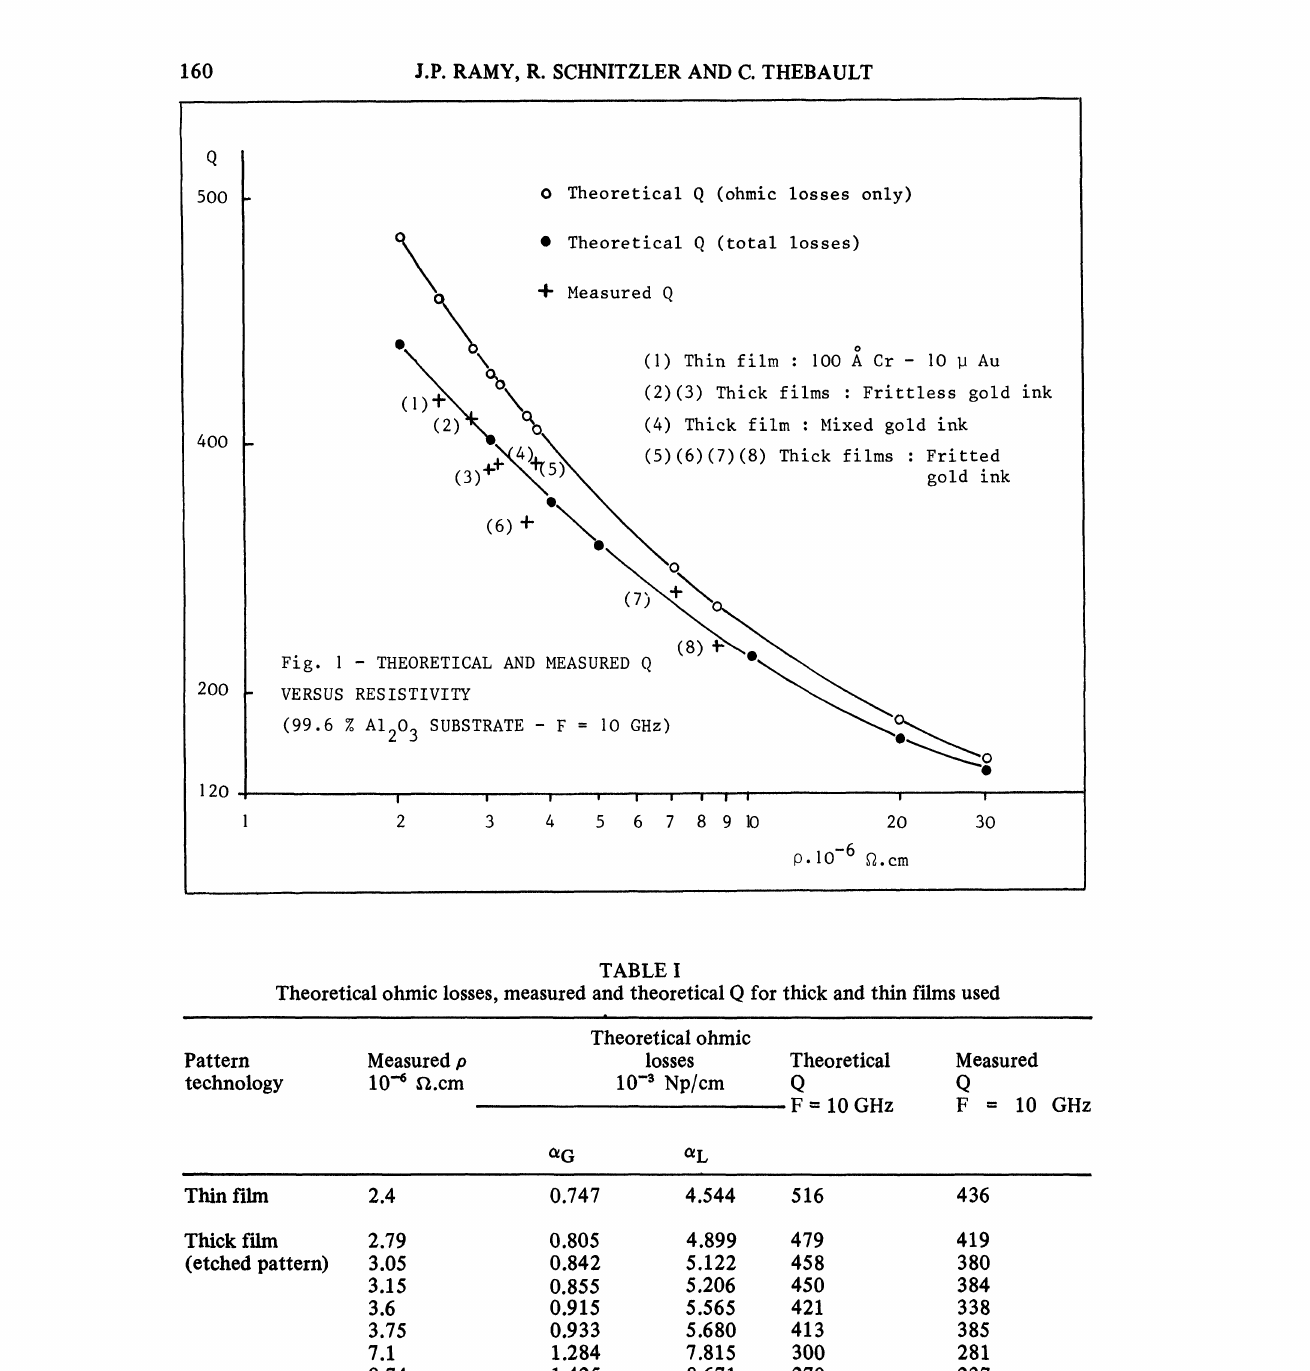
TABLE Theoretical ohmic losses, measured and theoretical Q for thick and thin films